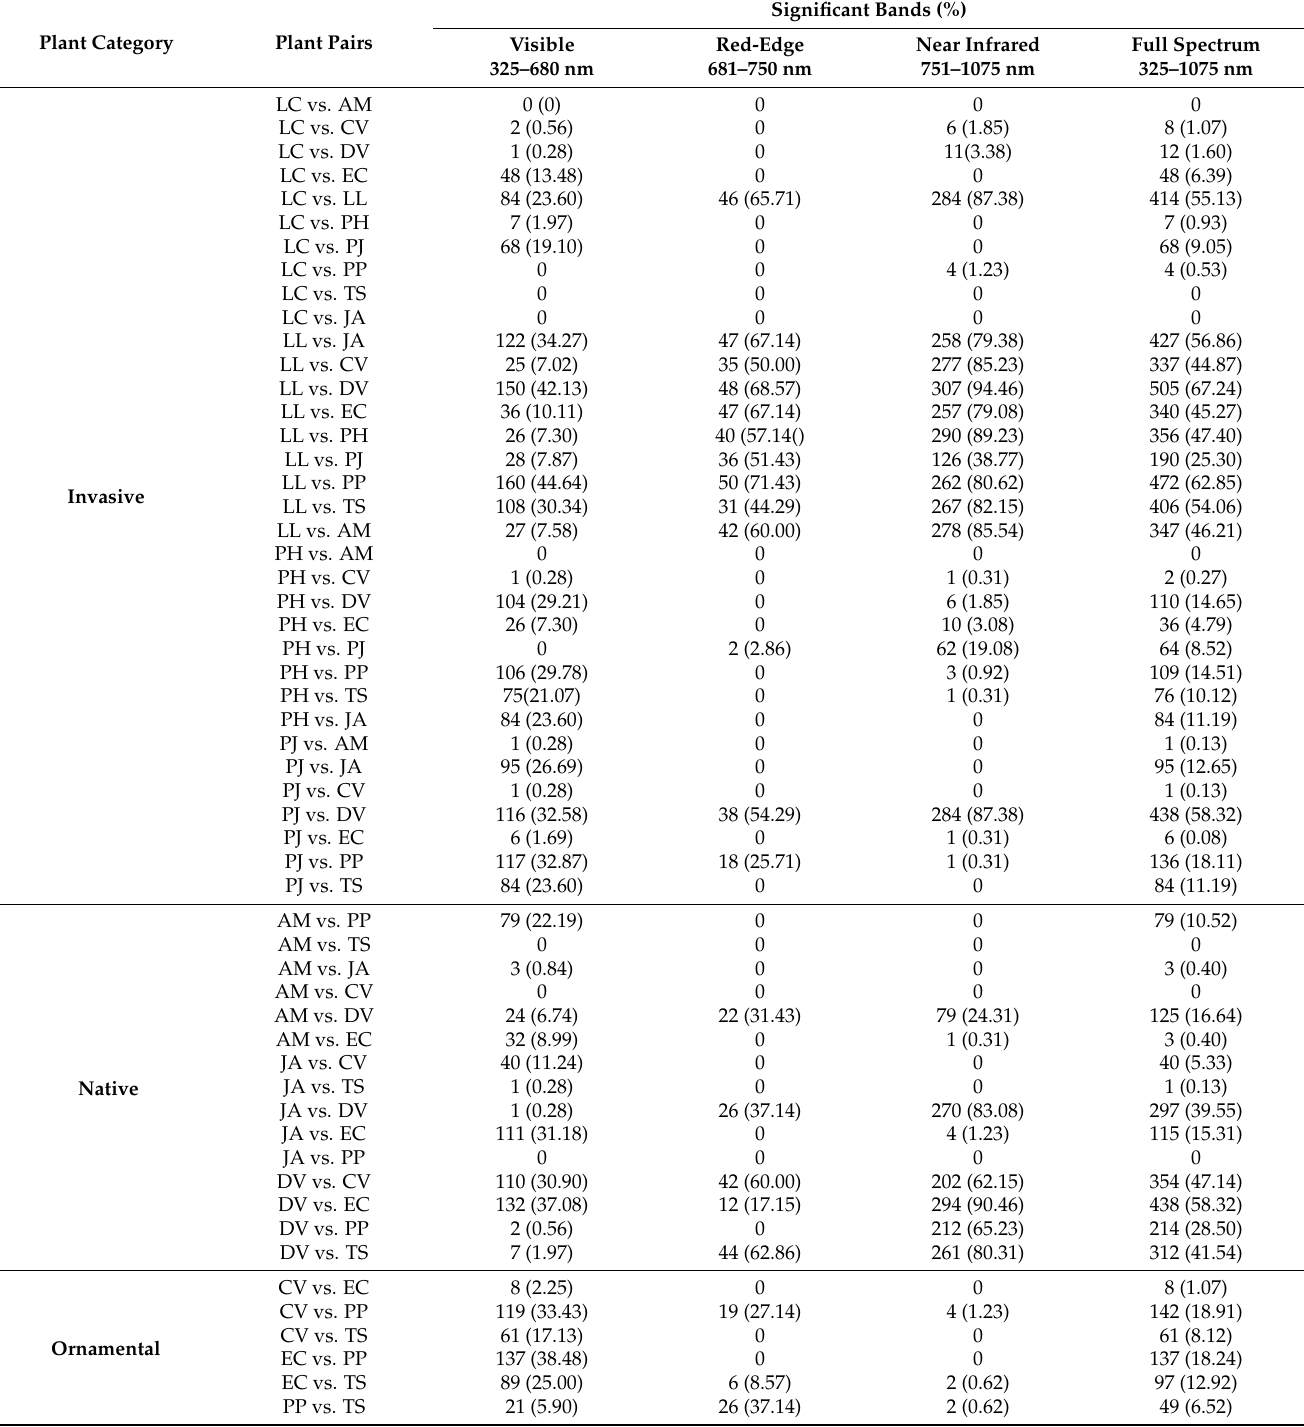
Table 5. Pairwise comparisons of all plant species (55 pairs) showing the frequency of significant wavelength bands in different regions of reflectance spectra. Values in parentheses represent percentage (%) of significant